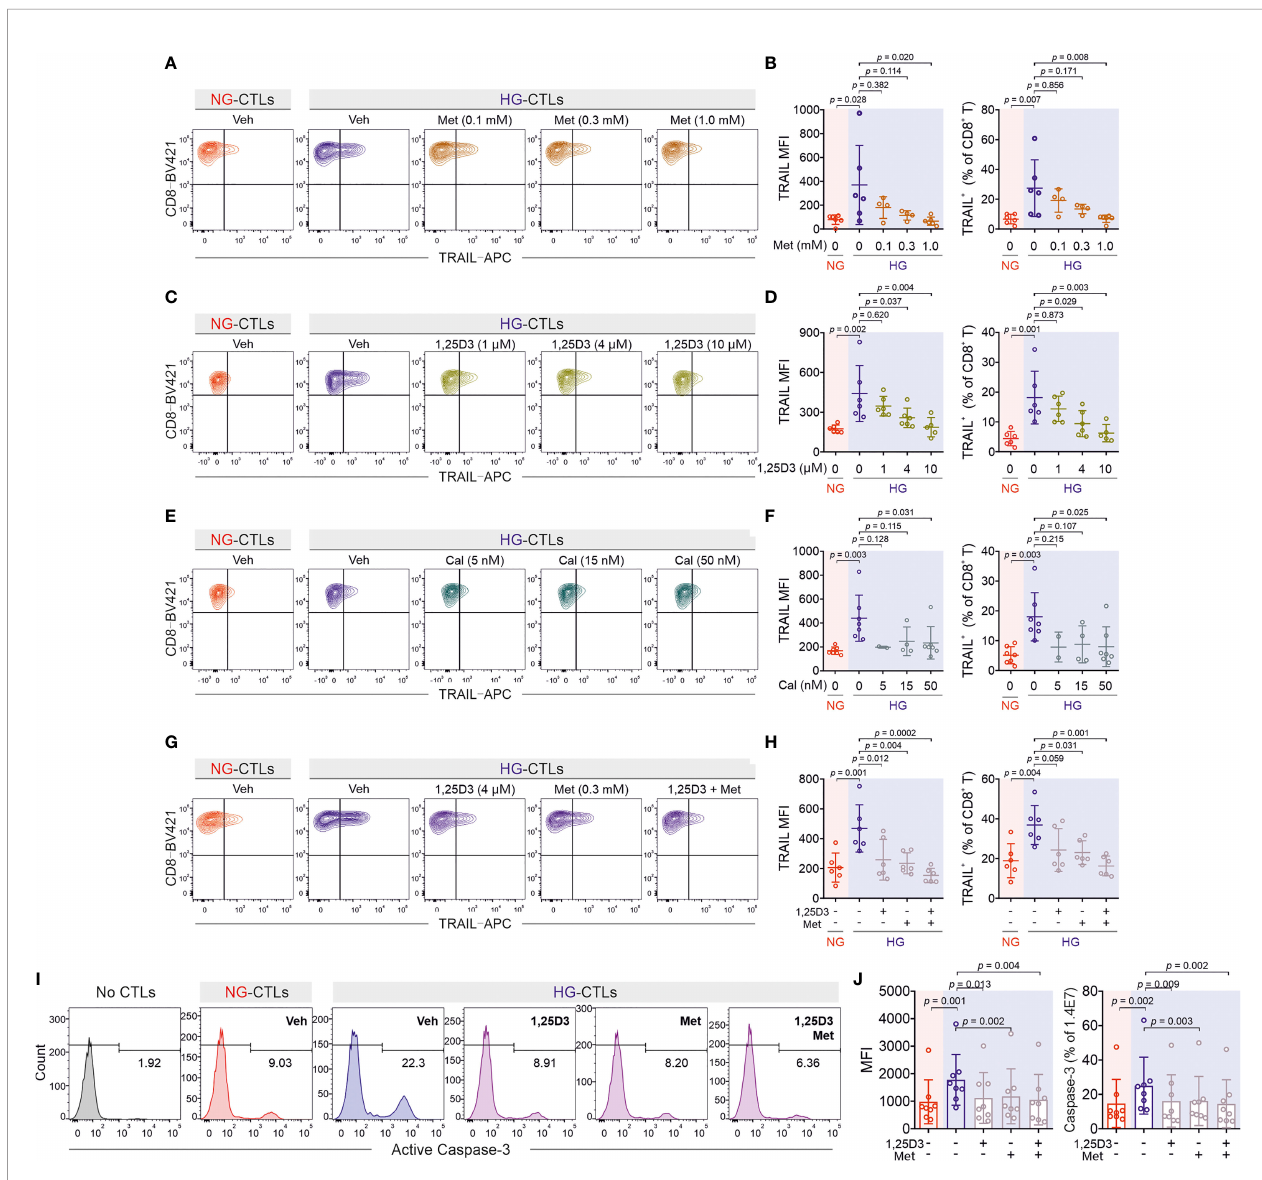
FIGURE 5 | Treatment of metformin and vitamin D rescues TRAIL-mediated pancreatic beta cell destruction. Primary human CD8 + T cells were stimulated with CD3/CD28 beads for 3 days in presence of metformin (Met), 1,25D3, or calcipotriol (Cal) with indicated concentrations. TRAIL expression was analyzed by fl ow cytometry. (A, B) Treatment of metformin reduces HG-enhanced TRAIL expression in CD8 + T cells (n = 4-6 donors from four independent experiments). (C, D) Vitamin D regulates TRAIL expression (n = 5-6 donors from four independent experiments). (E, F) Enhancement of TRAIL expression by HG could be downregulated by calcipotriol (n = 2-7 donors from four independent experiments). (G, H) The combination of metformin and vitamin D synergistically inhibits HG- enhanced TRAIL expression (n = 6 donors from three independent experiments). (I, J) Metformin and vitamin D can rescue HG-enhanced CTL-mediated beta cell apoptosis. Primary human CD8 + T cells were stimulated with CD3/CD28 beads for 3 days in presence of metformin (Met, 300 µM) and/or Vitamin D (1,25D3, 4 µM). 1.4E7 beta cells were co-incubated with CTLs for 4 hours. Results are from 8 donors from six independent experiments. Data are shown as means±SD. One-way ANOVA with Bonferroni ’ s multiple comparison test was applied for statistical